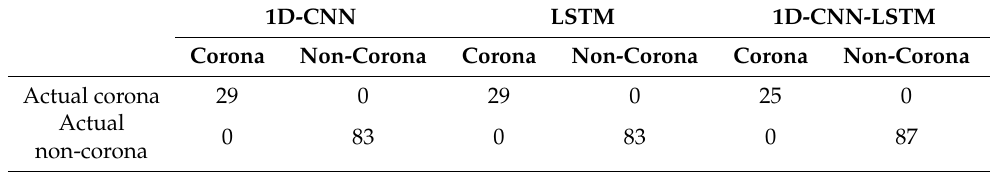
Table 10. Frequency domain corona fault classification output matrix for the training